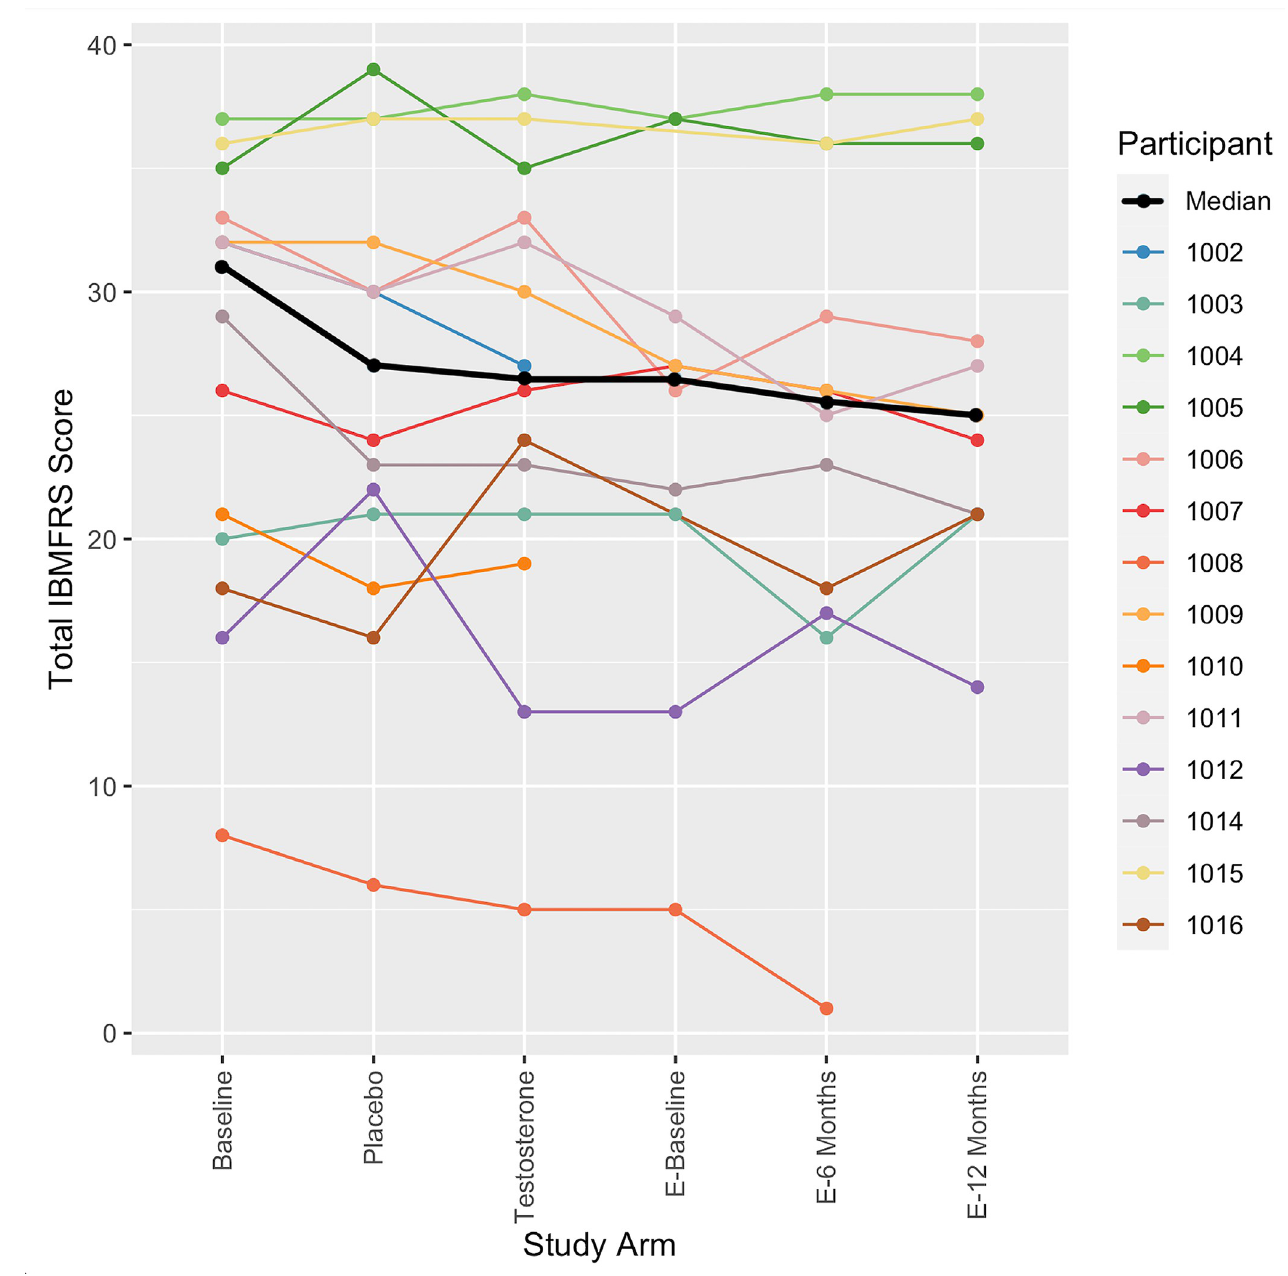
Fig 2. Change in IBM-FRS total score across the study period. The IBM-FRS consists of 10 questions, each of which can be scored 0–4. A score of 40 out of 40 indicates no impairment in function. This graph maps the change in total IBM-FRS score across the study arms. E-baseline = OLE baseline result , E-6 months = OLE 6 months result , E-12 months = OLE 12 months result . [2.09:21.83]) and Berg Balance test (mean difference [95% CI]: 11.84 [1.39:21.23]) improved across the OLE. The 30s sit-to-stand repetitions reduced across the OLE (mean difference [95% CI]: -4 repetitions [-7.86:-0.29]). IBMFRS and peak torque extension at 30 and 60 degrees were similar across the 12 month OLE, showing no significant decline (mean difference [95% CI]: -1 Nm [-8:6.29] and mean difference [95% CI]: 0.375 Nm [-3.75:3.25] respectively),